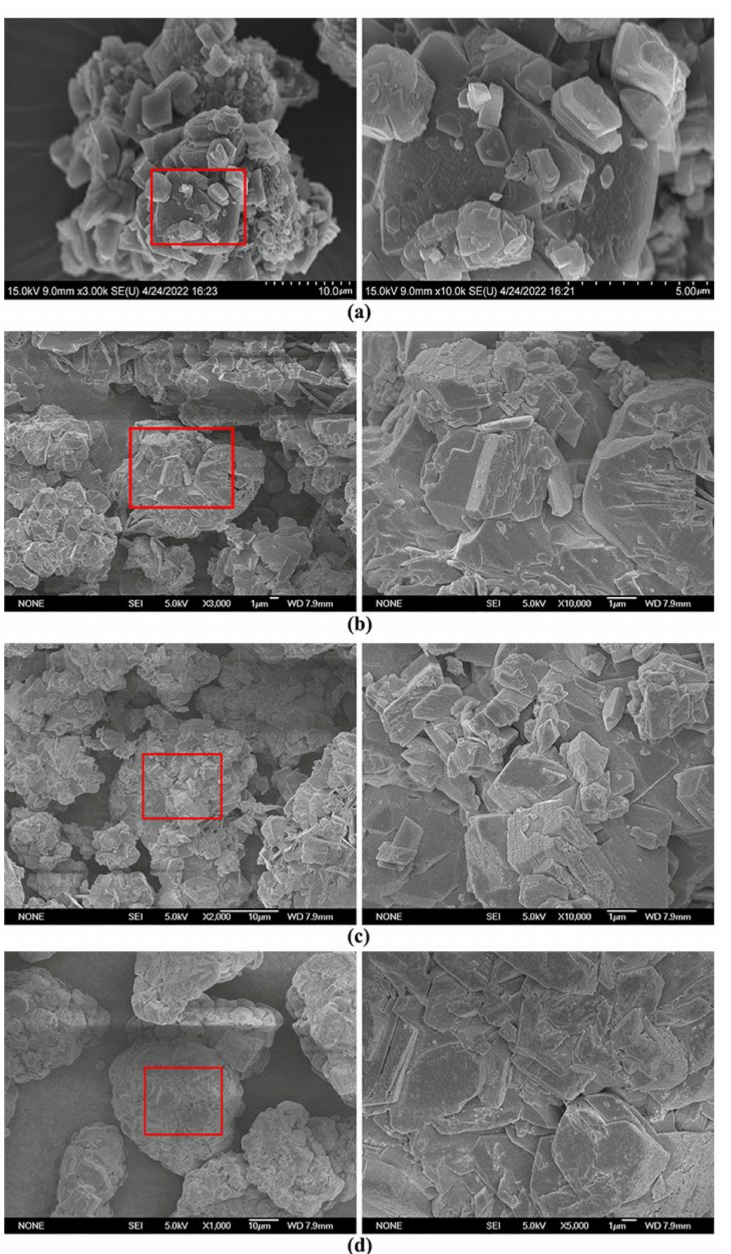
Figure 4. SEM images of composite samples: ( a ) vaterite-type precipitated calcium carbonate com- posite; ( b ) calcite-type precipitated calcium carbonate composite; ( c ) <500 mesh ground calcium carbonate composite; and ( d ) 400–500 mesh ground calcium carbonate